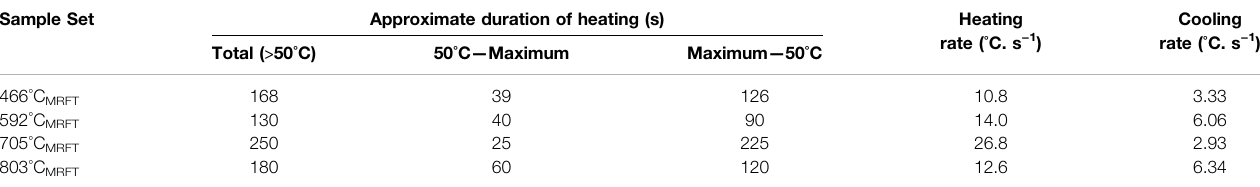
TABLE1| Tableindicatingthetotaldurationofheatingforeachprescribed fi resampleset,includingthetimetakentoreach,andcoolfrom,maximumrecordedtemperature. Heatingrateandcoolingratearealsohighlighted.Allvaluesarepresentedtothreesigni fi cant fi gures,andconsideredstrictlyapproximategiventherecordingcapabilites and resolution of implemented thermocouples. Durations of heating are derived from times recorded immediately before and after 50 ° C is measured, and therefore may includelowertemperaturesthan50 ° Cdependingontherateofincreasebetweenmeasurements.Valuesat466 ° C MRFT donotcorrespondtotherecordedtotaldurationasa result of the sustaining of maximum recorded temperature for 3 s.